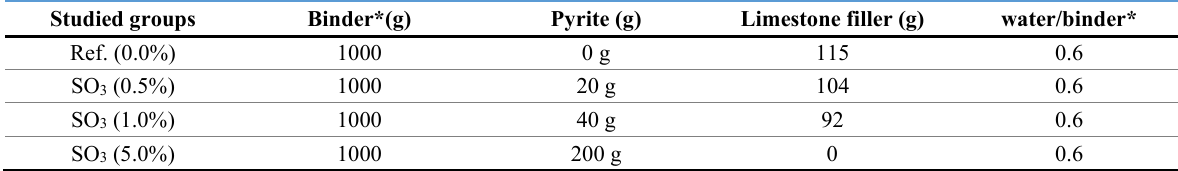
Table 3. Mix proportion for the four studied